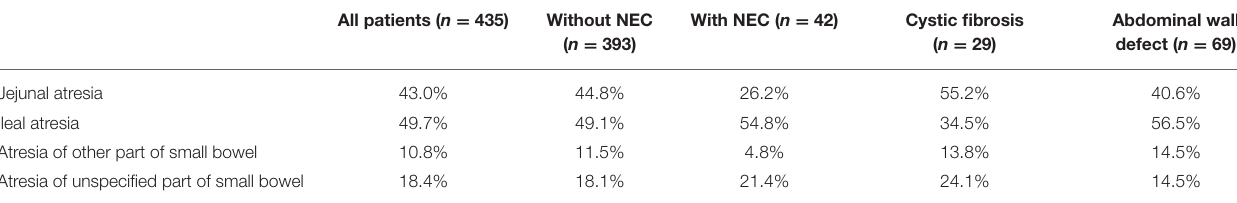
TABLE 2 | Distribution of types of JIA in all patients and different groups of patients. All patients ( n = 435) Without NEC With NEC ( n = 42) Cystic fibrosis Abdominal wall ( n = 393) ( n = 29) defect ( n = 69) Jejunal atresia 43.0% 44.8% 26.2% 55.2% 40.6% 49.7% 49.1% 54.8%